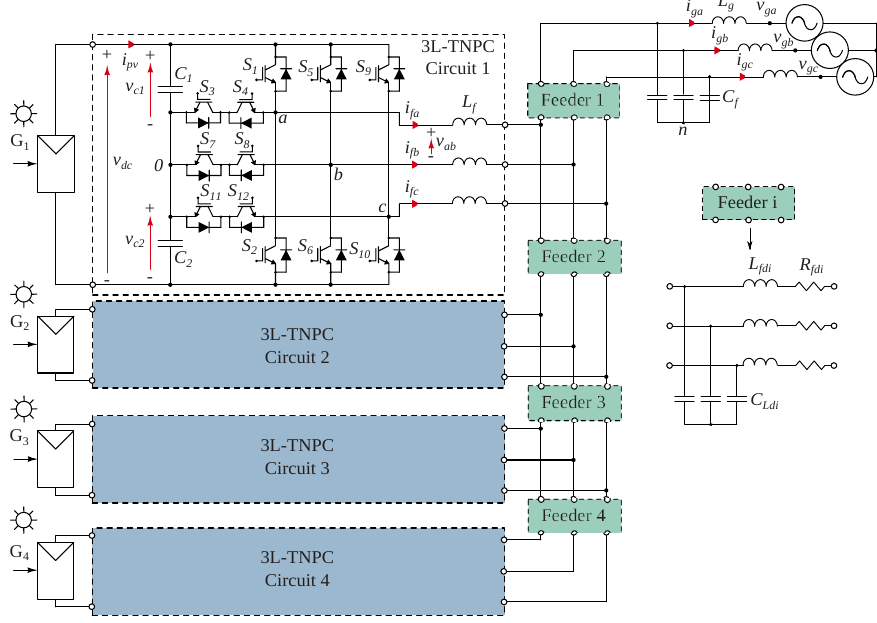
Figure 1. Multiple utility-interactive 3L-TNPC converter PV central